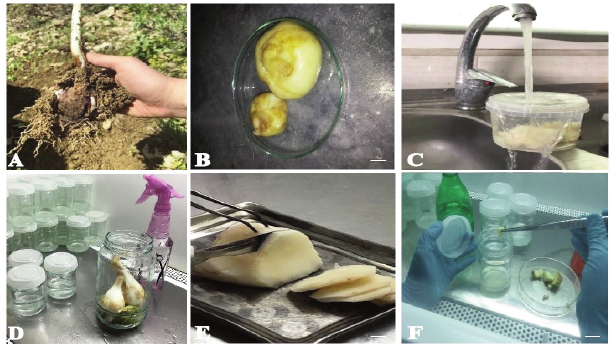
Fig. 2 ­ Sterilization of bulbs and preparation of scales explants.